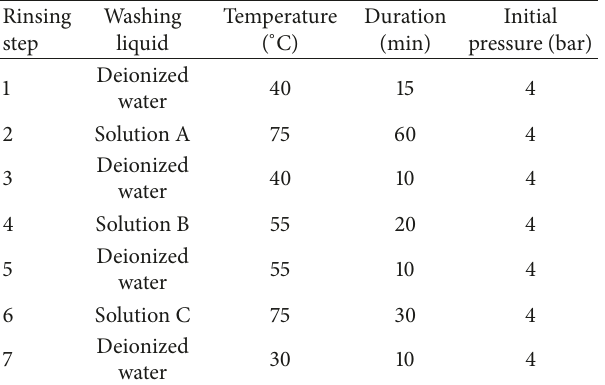
Table 1: Scheme for the washing procedures of the nanofiltration membranes.